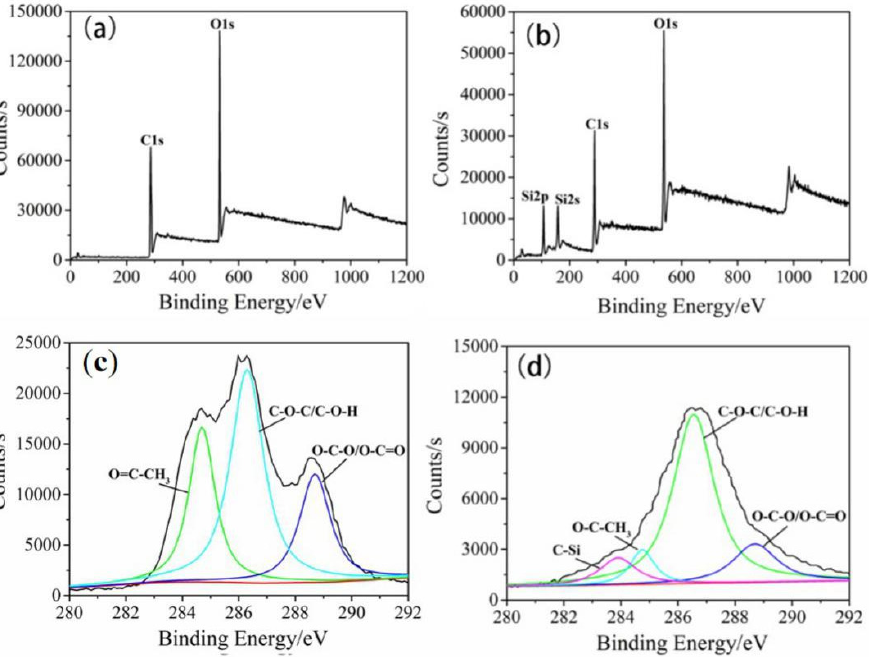
Figure 13. XPS spectrum: ( a ) Full spectrum of CA, ( b ) Full spectrum of Janus–CA hydrophobic surface, ( c ) C1s peak split: CA, ( d ) C1s peak split: Janus–CA hydrophobic surface.